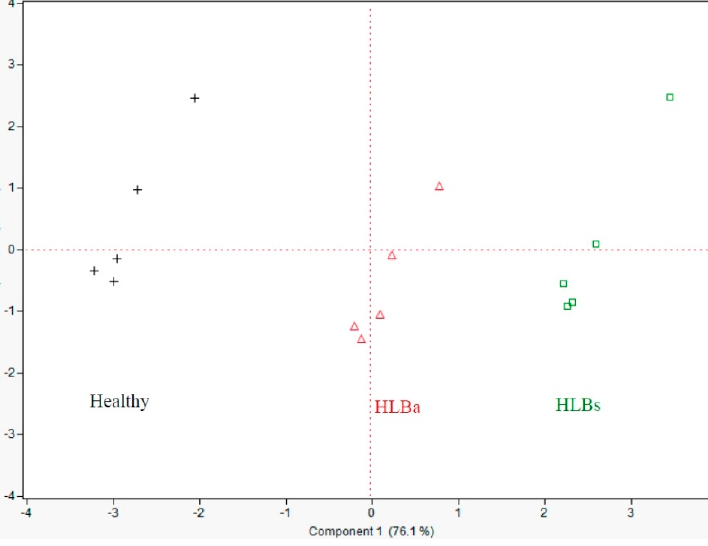
Figure 6. Principal components analysis showing e-tongue separation (sensor set #5) of Hamlin orange juice from fruit harvested from healthy, HLB asymptomatic (HLBa) and HLB symptomatic (HLBs) trees in February 2011 in South Florida.